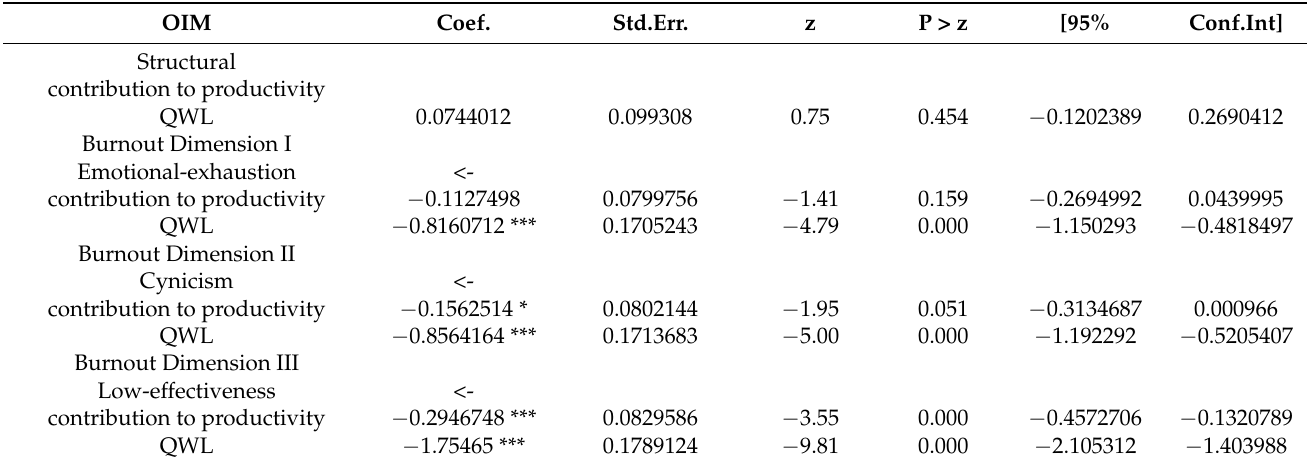
Table 5. Model 1: Total